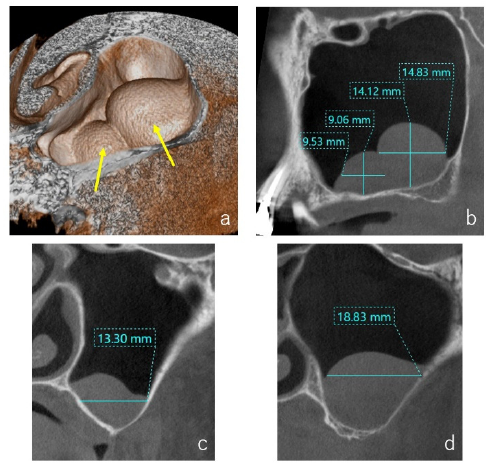
Figure 1. Case: 62 years old female. Two cystic lesions were observed in the left maxillary sinus by the volume rendering image (( a ), yellow arrows). A sagittal section of the CT image showed two well-defined ‘dome-shaped’ faintly radiopaque lesions, and the size of mesiodistal and vertical lengths were measured ( b ). On the buccolingual section of the CT image, the buccolingual length of the medial ( c ) and distal ( d ) cystic lesions were